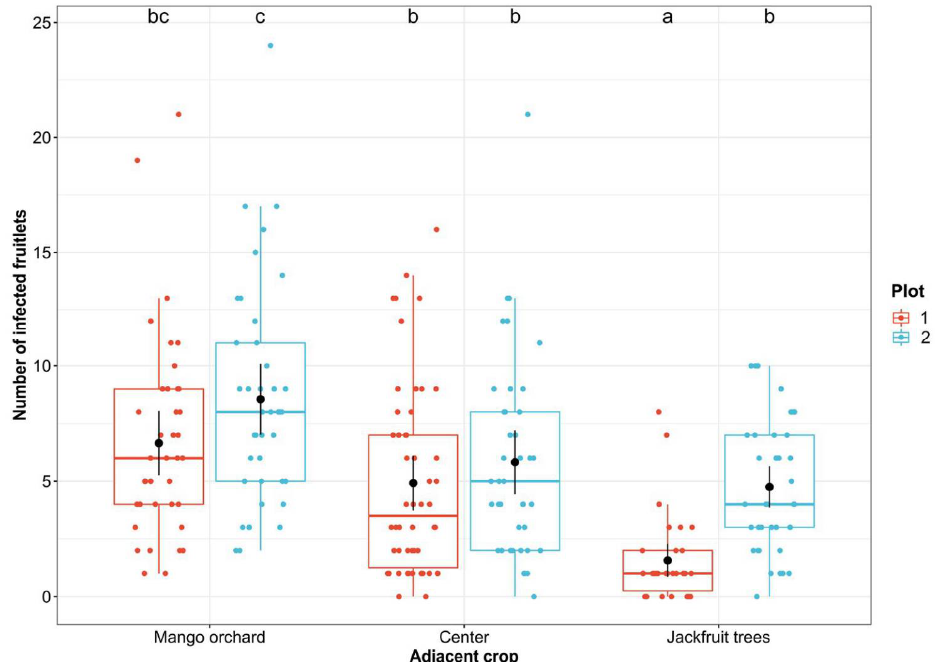
Figure 3. Scatter and box plots of numbers of FCR-infected fruitlets (IF) per pineapple fruit in the function of the adjacent crop according to plot orientation (Plot 1: Red, Plot 2: Blue). Black dots with bars show mean numbers of IF per pineapple with asymptotic confidence intervals at 95%. Letters indicate significant average differences between plot x sections ( n = 40) according to Tukey’s multiple comparison test ( p ≤ 0.013).